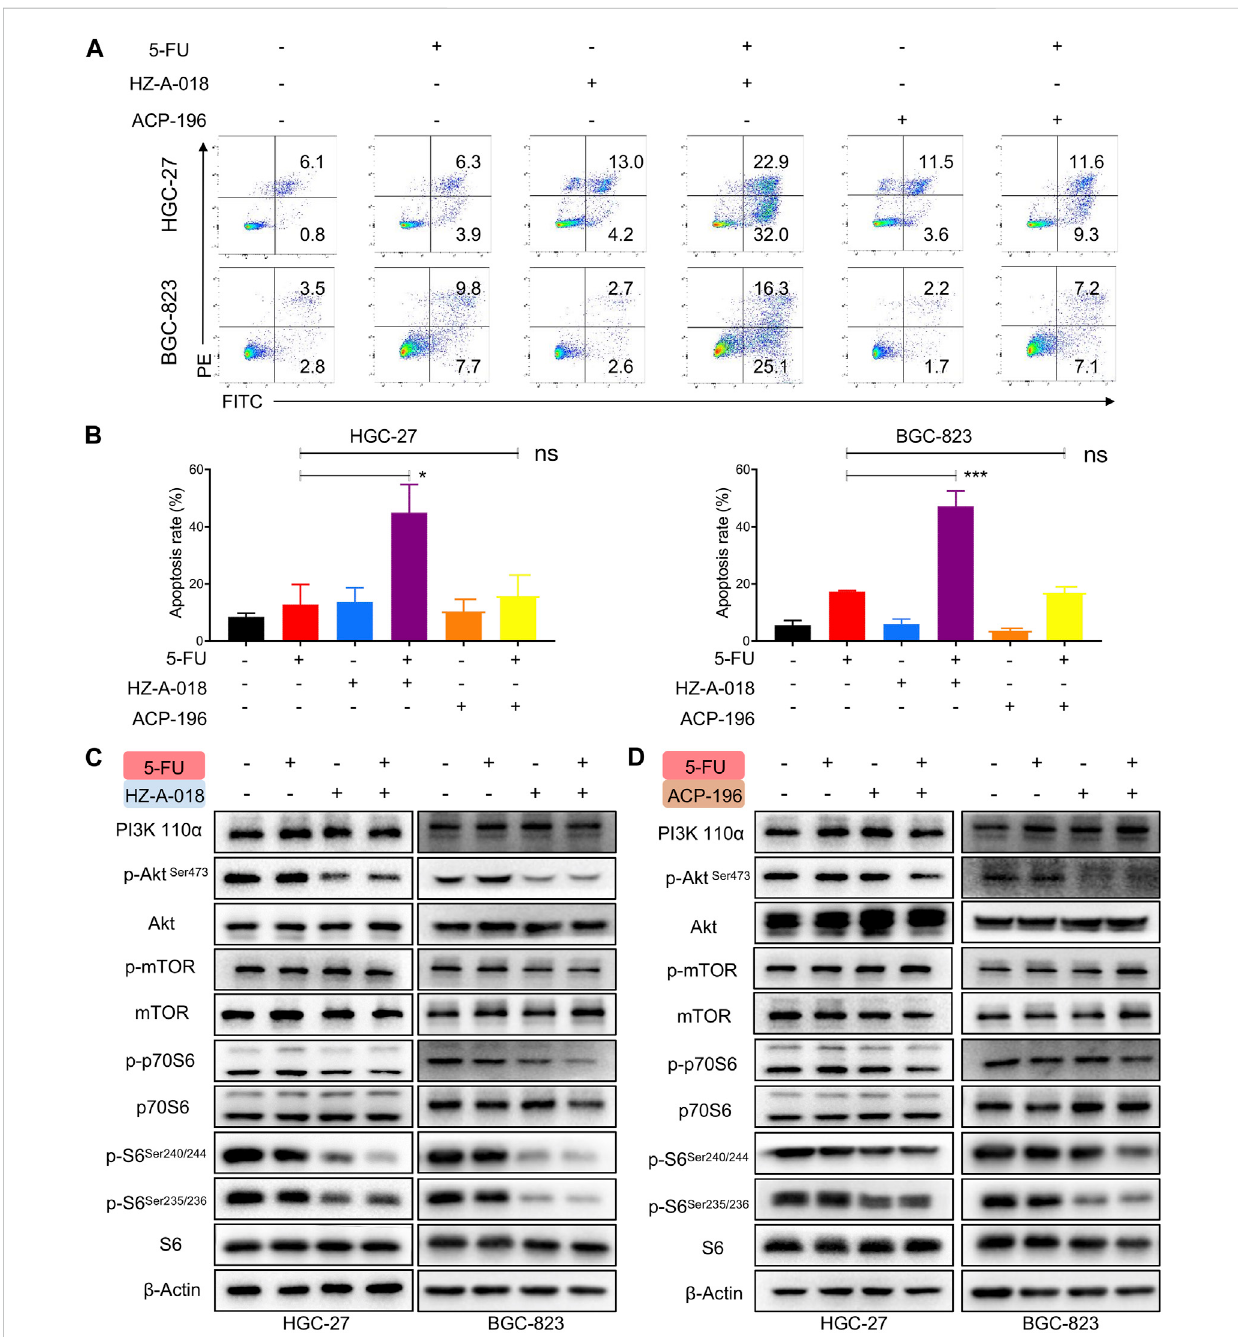
FIGURE 2 The combined effects of 5-FU and HZ-A-018/ACP-196 on apoptosis and AKT/S6 pathway of gastric cancer cells. (A) Flow cytometric analysis of apoptoticcellsaftercombinatorialtreatmentwith5-FU(5 µMinHGC-27cells,0.5 µMinBGC-823cells)and10 µMofHZ-A-018orACP-196for72 h.